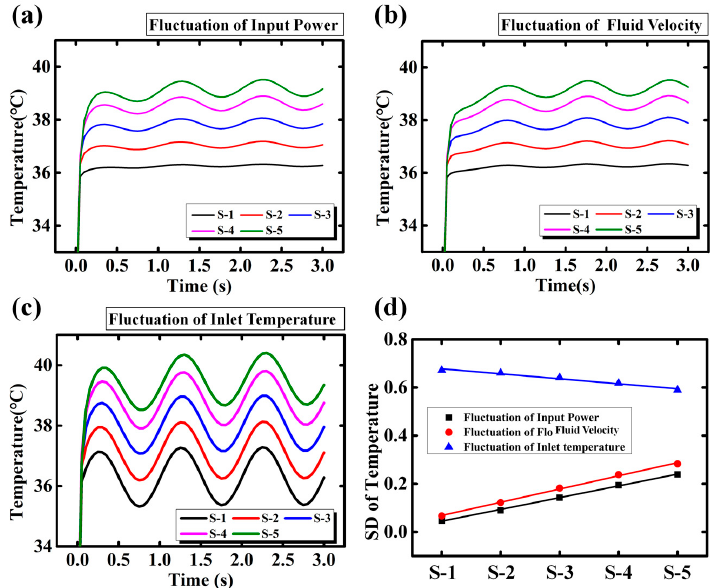
Figure 6. The simulation results of different sinusoidal single variances: ( a ) input power; ( b ) flow rate and ( c ) inlet temperature; ( d ) standard deviation of temperature fluctuation from inlet to outlet (S-1 to S-5) of different sinusoidal single variances.